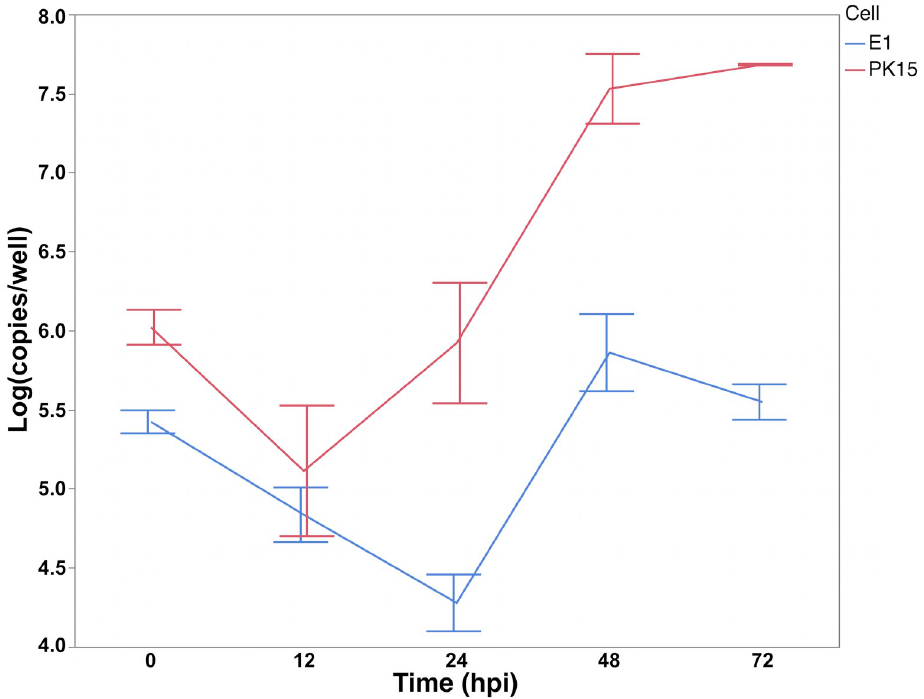
Fig 11. PCV2 copy number in E1 and wildtype PK15 cells following inoculation with the UNL2014001 PCV2b strain. The number of viral copies from PK15 cells is expressed as log10 copies/well.